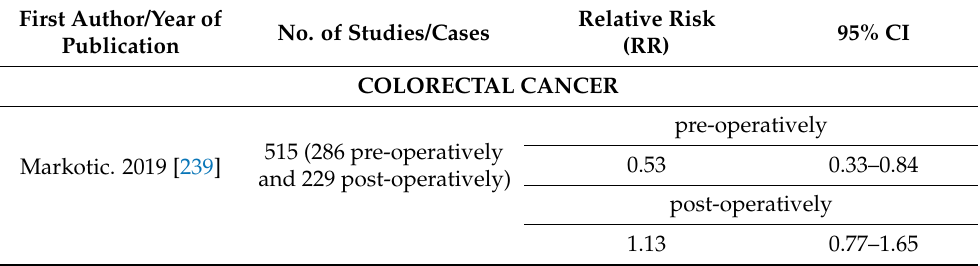
Table 3. The effect of preoperative and postoperative 25 (OH) D levels on the OS in patients with colorectal